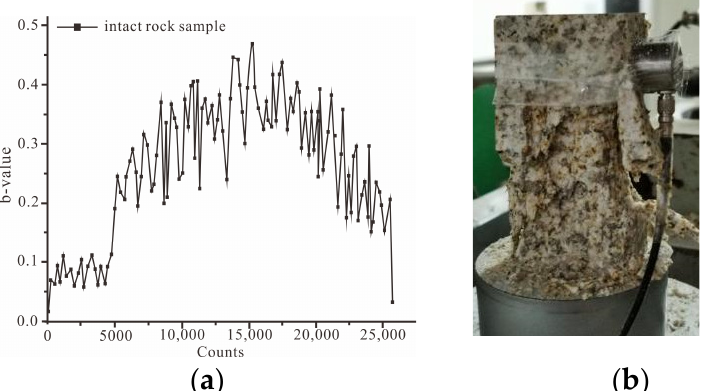
Figure 11. The b -value of intact rock sample. ( a ) The curve of the b -value of intact rock sample; ( b ) the failure of intact rock sample.